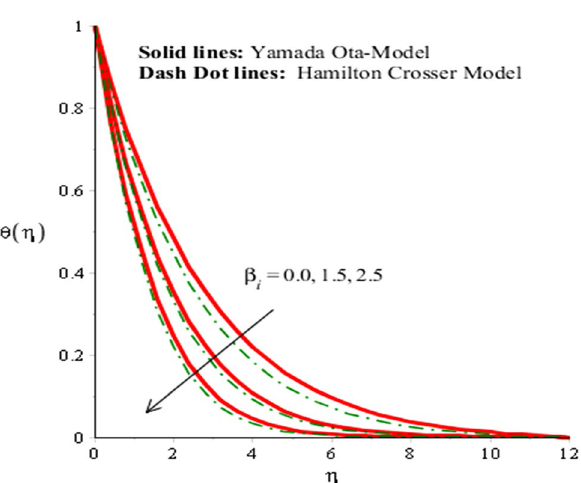
Figure 7. Analysis of heat energy field in against β i when ∅ 1 = 0.002, ∅ 2 = 0.0075, (cid:31) = 4.0, β e = 0.3, α = 2.0, β = 0.2, Pr = 206, Ec = 4.0, H s = 0.2, M =